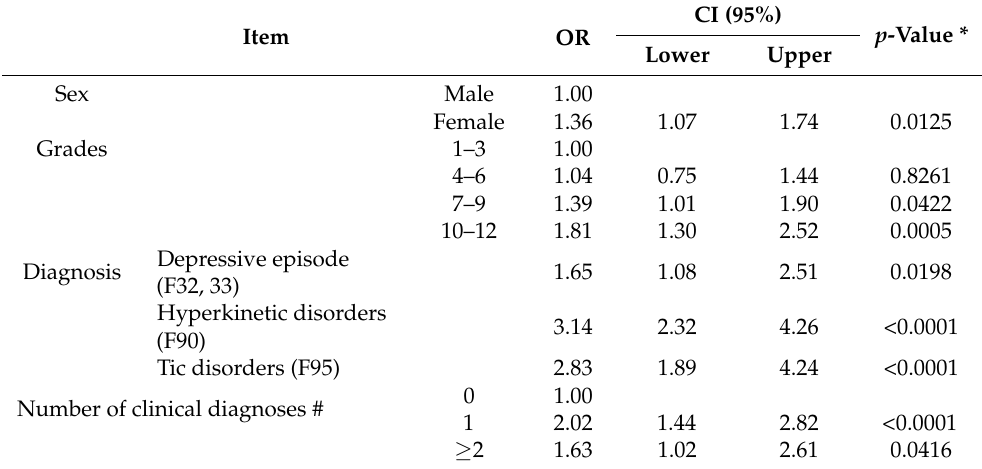
Figure 2. Distribution of mental disorders in female patients by year ( p value of slope, * <0.05). Table 2. Factor analysis for the treatment continuity defined as more than three outpatient